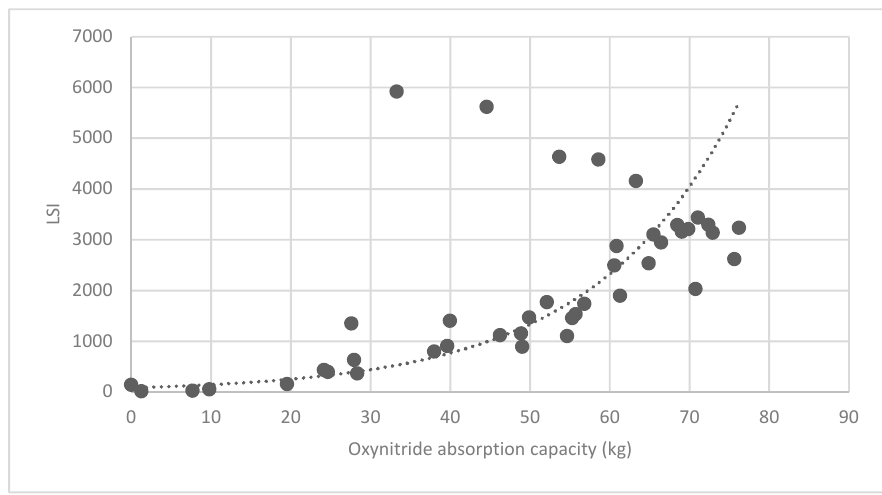
Figure 32. Association between brush LSI and oxynitride absorption capacity.